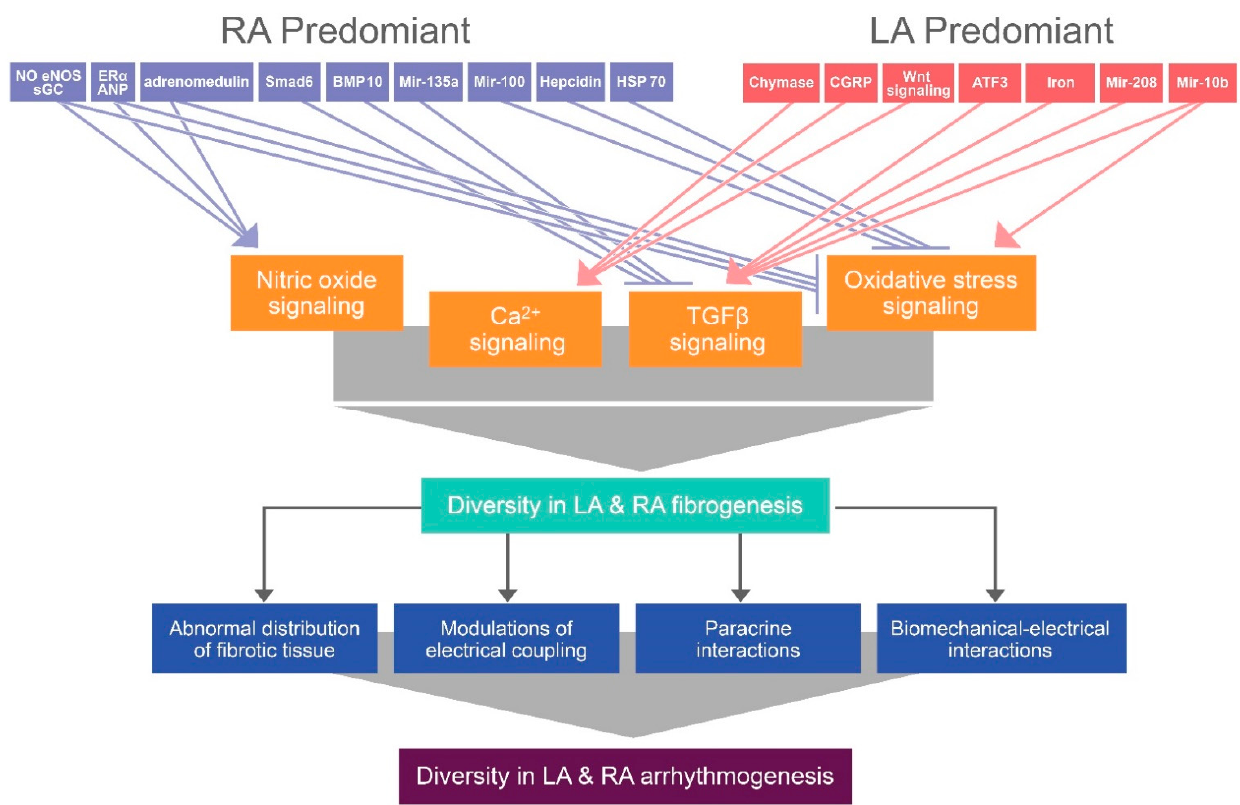
Figure 3. Illustration of the proposed mechanism that contributes to differential atrial fibrogenesis-induced arrhythmo- genesis between the LA and RA. Diverse gene or protein expression induces differential atrial fibrogenesis by modifying nitric oxide, Ca 2+ , transforming growth factor (TGF)- β , and oxidative stress signaling, thereby activating diversity in atrial arrhythmogenesis through the abnormal distribution of fibrotic tissue, modulations of electrical coupling, paracrine inter- actions, and biomechanical–electrical interactions. ER α : estrogen receptor- α , eNOS : endothelial nitric oxide synthase, sGC : soluble guanylyl cyclase, ANP : atrial natriuretic peptide, Smad6 : SMA and MAD-related protein 6, BMP-10 : bone morpho- genetic protein-10, HSP-70 : heat shock protein-70, Mir : micro RNA, CGRP : calcitonin gene-related peptide, ATF3 : activat- ing transcription factor 3.